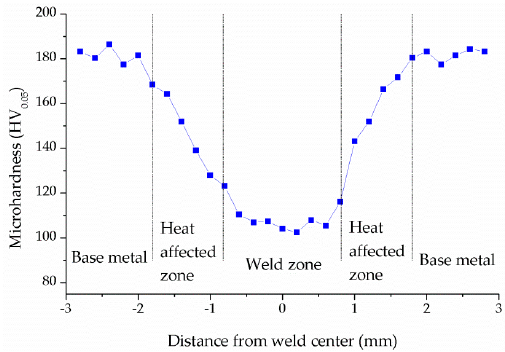
Figure 10. Results of microhardness.